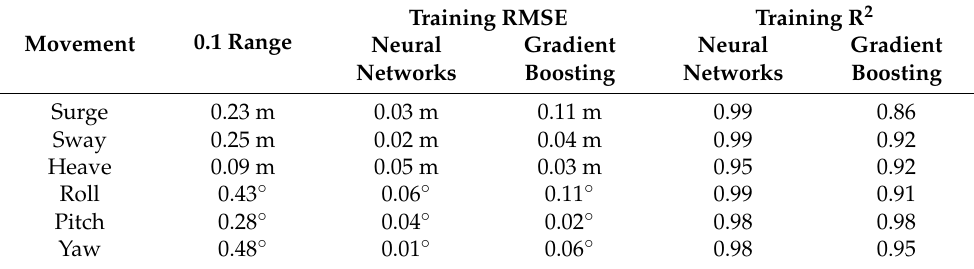
Table 4. Training error for neural networks and gradient boosting.